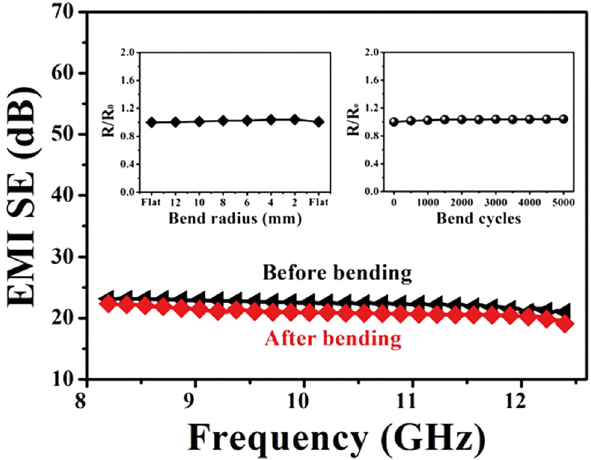
Figure 2: EMI SE of the 5.0 wt% CNT - loaded composite ( 0.4 mm thickness ) before and after repeated bending to the radius of 2.0 mm for 5,000 times. Left inset shows the variation in the normalized resistance ( R / R 0 ) of the 5.0 wt% s - GTR composite as a function of the bending radius. Right inset shows the R / R 0 as a function of bending cycles ( radius of 2.0 mm ) [ 10 ]